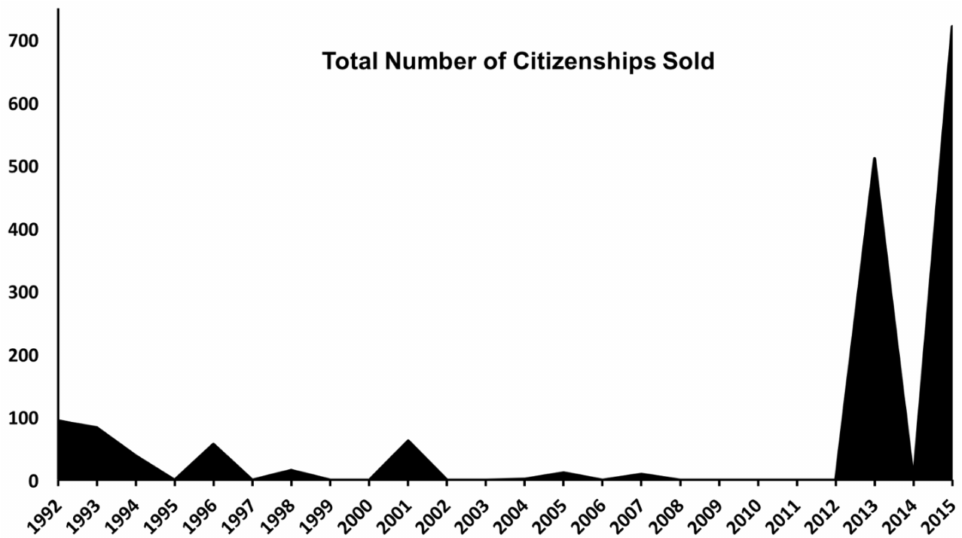
Figure 1. Total number of citizenships sold. Source: Data collected by the author for the period 1990–2015 17